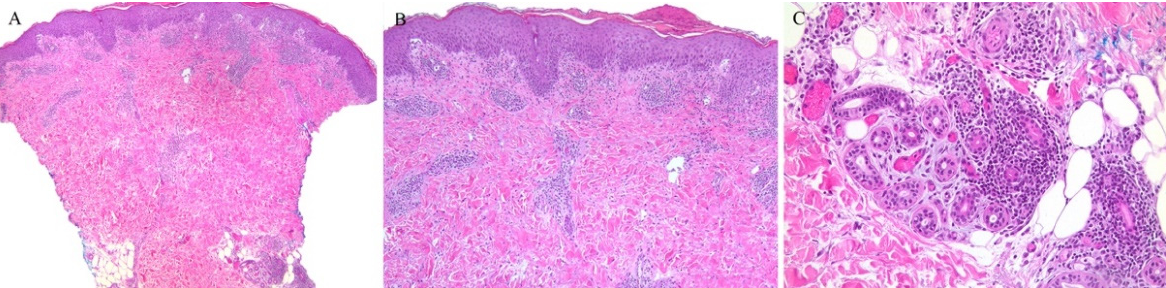
Figure 8. ( A – C ) Pityriasis lichenoides chronica with perieccrine involvement.